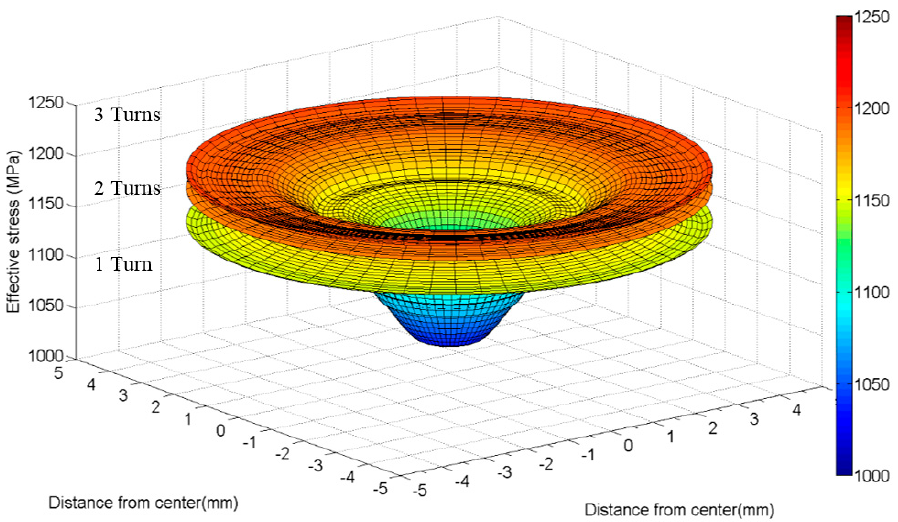
Figure 7. Distribution of effective stress across the disc surface after processing by HPT for 1, 2, 3 turns under 3 GPa pressure.